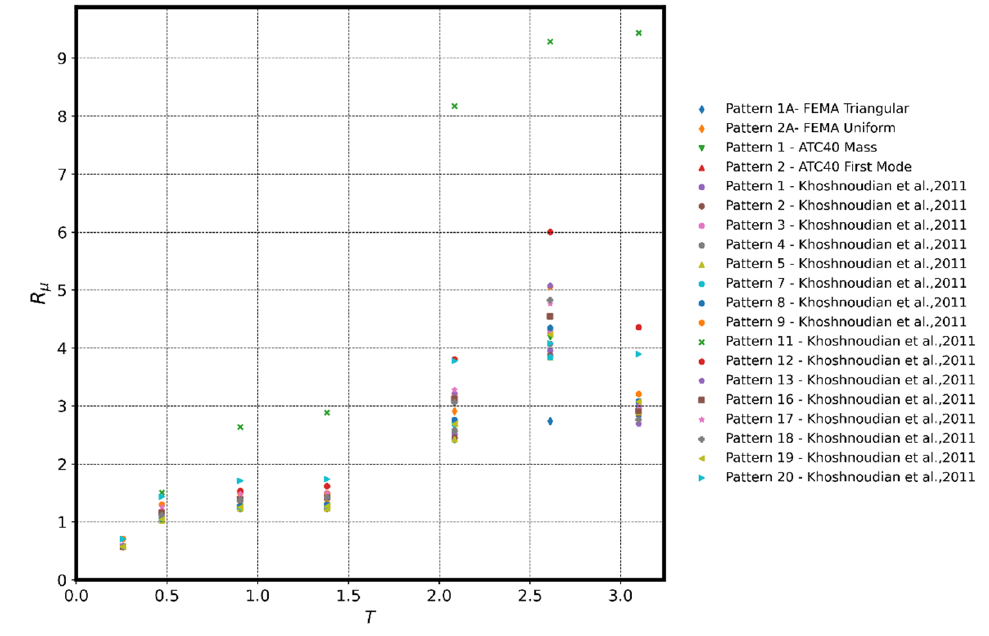
Figure 7. Ductility reduction factor versus period for different patterns.